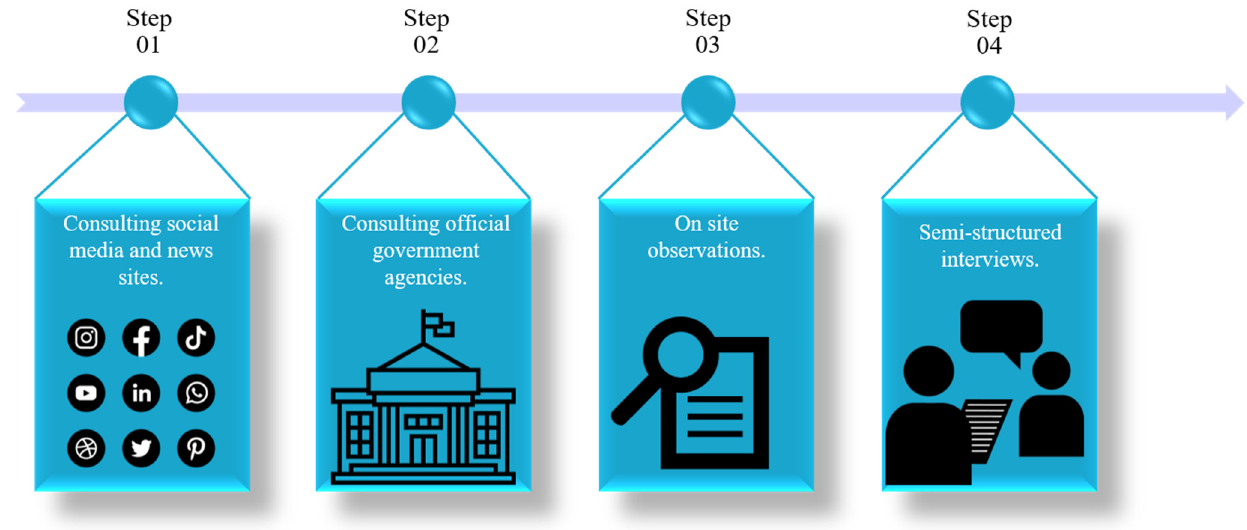
Figure 2. Steps to obtain social perception data about a flood event.